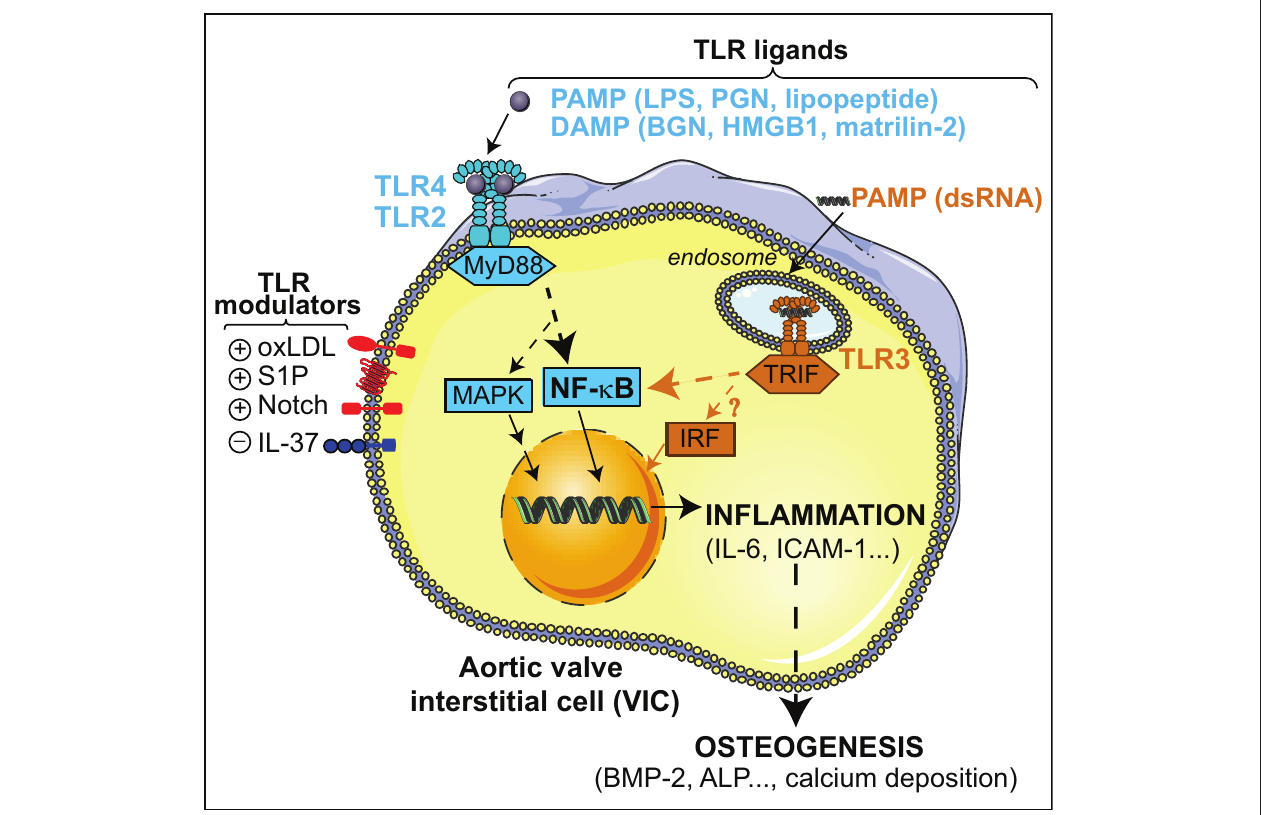
FIGURE 1 | Overview of the TLR signaling pathways triggered by PAMPs and DAMPs in VIC. TLR2/4-MyD88 stimulation leads to NF- κ B and MAP kinases activation and the subsequent induction of inflammatory mediators that promotes osteogenic reprogramming of VIC. Endosomal TLR3-TRIF stimulation triggers a non-canonical NF- κ B signaling, and most likely IRF activation, thus promoting up-regulation of inflammatory and osteogenic mediators. Putative endosomal TLR4 signaling and TLR4-independent mechanisms are not depicted. ALP, alkaline phosphatase; ICAM-1, Intercellular Adhesion Molecule 1; PGN, peptidoglycan.